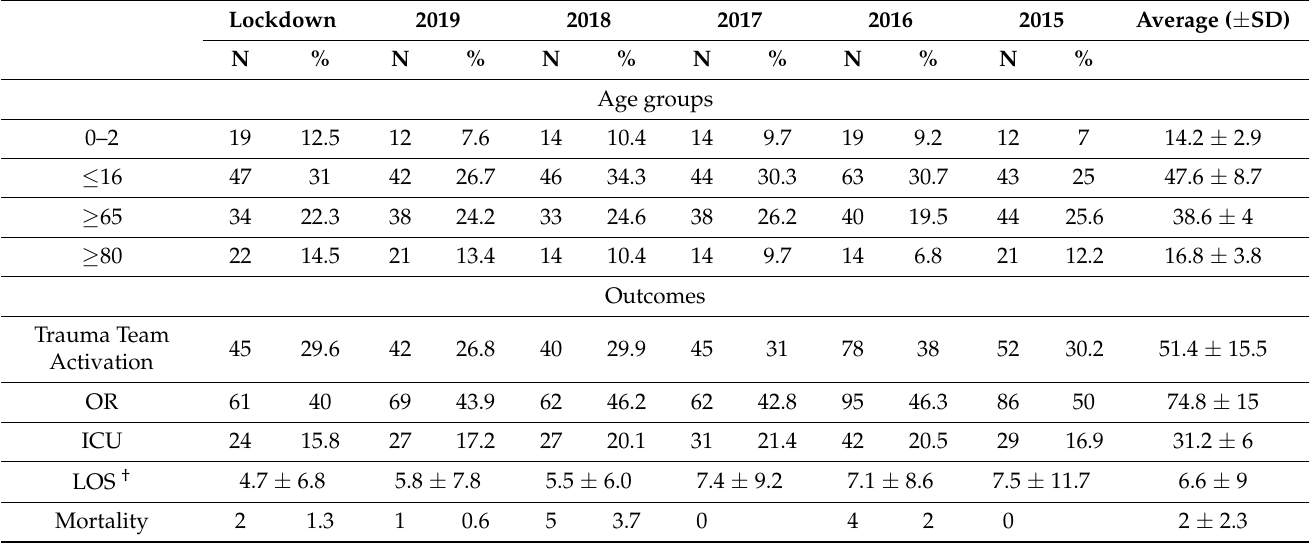
ISS—Injury severity score; OR—number of patients that required operations: ICU—number of patients that required an intensive care unit stay; LOS—hospital length of stay (in mean ± standard deviation); * p = 0.02;